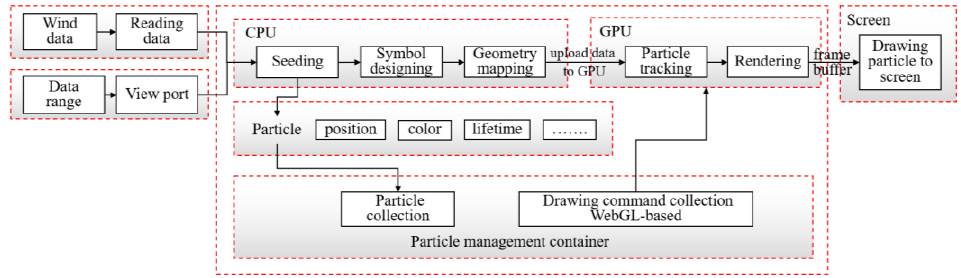
Figure 4. The diagram of the particle system manager structure.